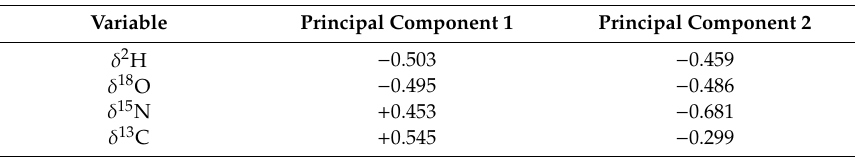
Figure 3. Principal Component Analysis through a Bi-plot presentation on New Zealand casein samples using four variables ( δ 13 C, δ 15 N, δ 2 H and δ 18 O). The colour of individual points was determined from the average of PC1 and PC2 scores. As the scores of PC1 and PC2 increase from lowest to the highest, the colour frequency of the points increase from red to blue (in correspondence to a visible color spectrum). Table 2. PCA loadings for PC1 and PC2 in correspondence to the four variables ( δ 2 H, δ 18 O, δ 15 N and δ 13 C) which were used in this